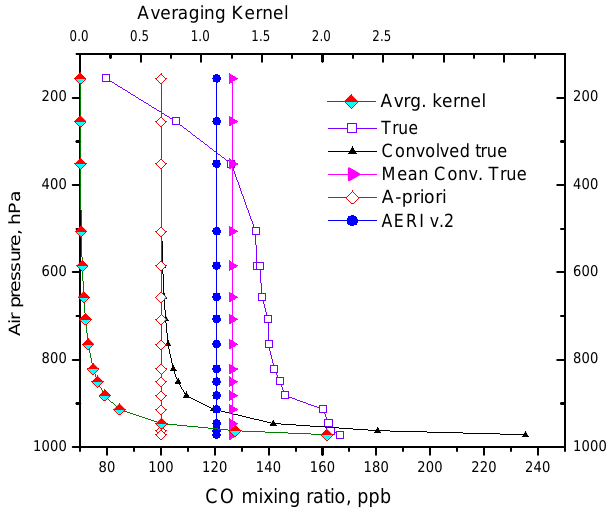
Fig. 2. A comparison of CO retrieved from the AERI spectra for 1630–1730 UTC, 27 April 2006, with the independently derived data. The composite (“true”) profile consists of the in situ tower measurement, in situ aircraft data (below 600hPa level, from 16:36 to 18:15UTC), and AIRS v5 L3 product for 27 April 2006, around 1900 UTC. Black triangles are for composite profile convolved with the AERI averaging kernel. Magenta triangles are used for the convolved composite profile averaged over the altitude. Also plot- ted are the constant 100ppbv a priori CO profile (red diamonds), the AERI v2 retrievals averaged between 16:30 and 17:30UTC (blue circles), and the CO averaging kernel calculated for the given